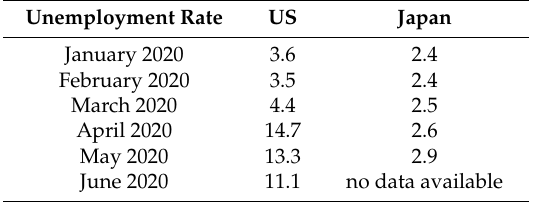
Table 1. Unemployment rate in the US and Japan between January 2020 and June 2020 (in %) Unemployment Rate